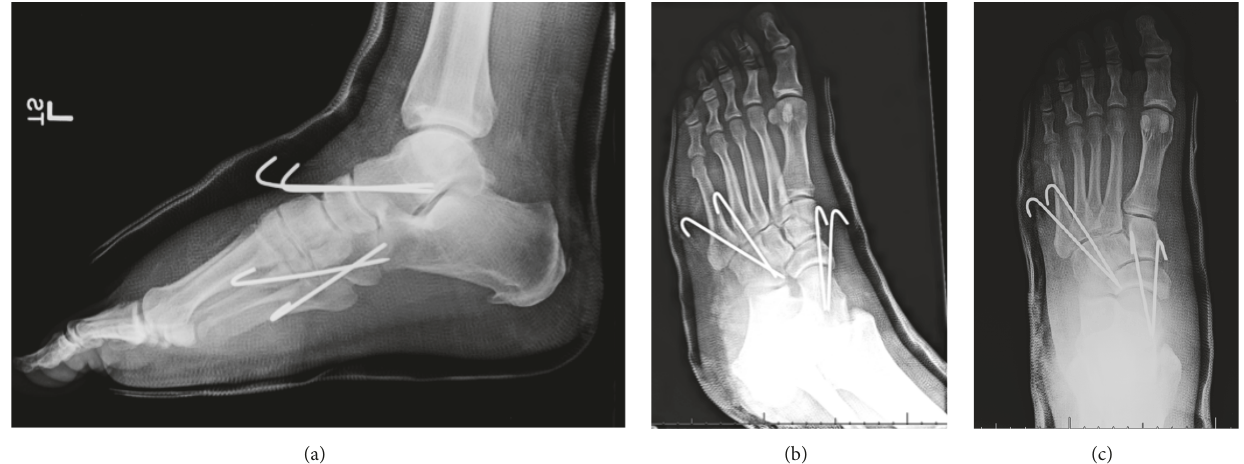
Figure 5: Postoperative radiographs demonstrating stabilization of the fourth and fifth tarsometatarsal joints and talonavicular joints with pins.